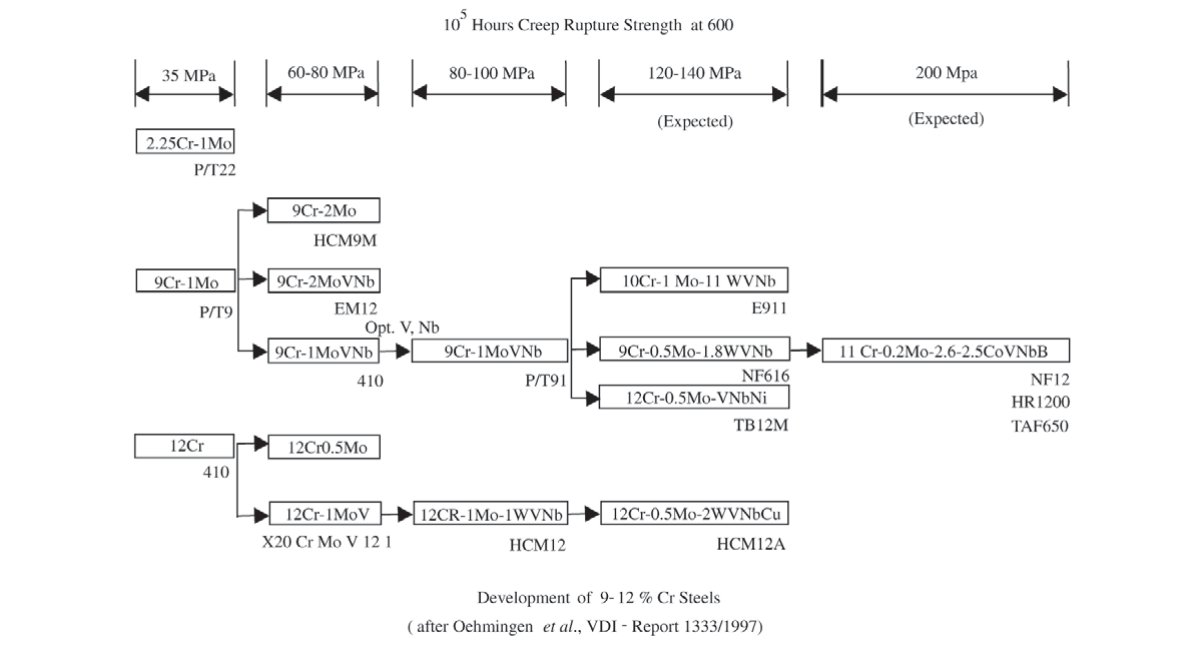
Figure 1. Development of modern 9-12% Cr steels 1